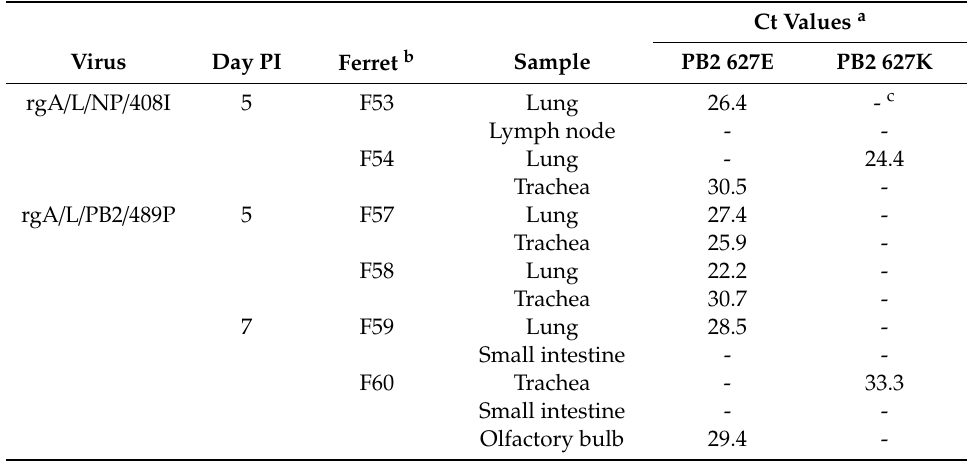
Table A3. A / Laos PB2 627 SNP analysis following infection of ferrets with reverse-engineered H5N1